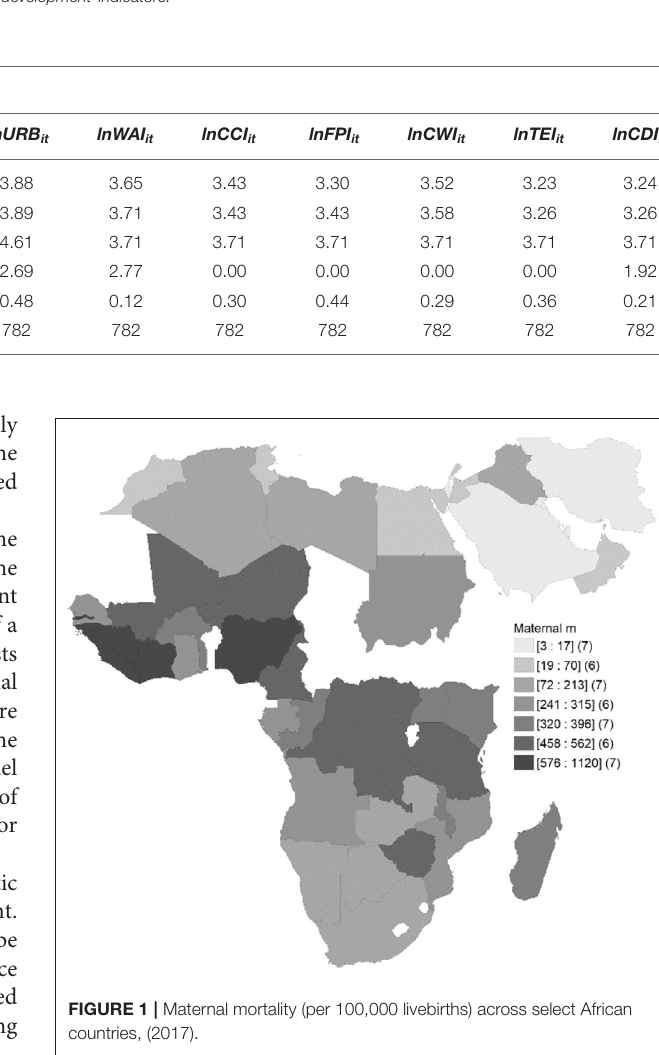
Hausman test reject the assumption of random effects in the spatial lag model for all the models and confirm the existence of fixed effects at a significance level of